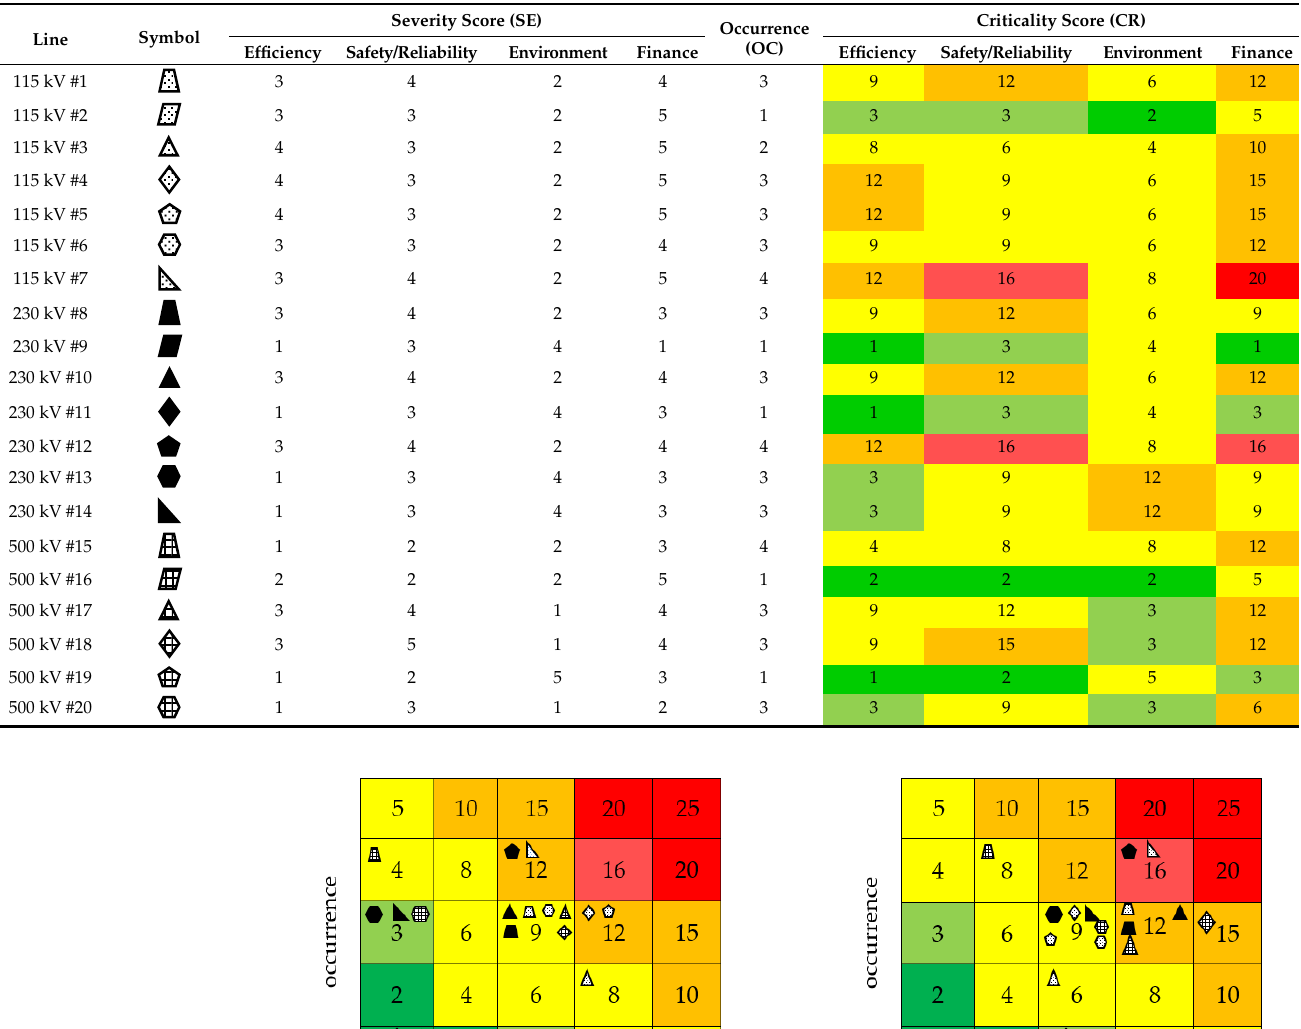
Figure 4. Criticality matrix of the sample 230 kV transmission line towers no. 1, line no. 8. Next, the severity and criticality of 20 transmission lines were determined. The criti- cality scores (CR) of all transmission lines were calculated and are summarized in Table 12. These scores were then plotted in criticality matrices of efficiency, environment, safety/reliability, and finance, as shown in Figure 5. The practical data of the 20 transmis- sion lines are analyzed and summarized in Table 13. Table 12. Severity and criticality analysis of the 20 transmission lines.